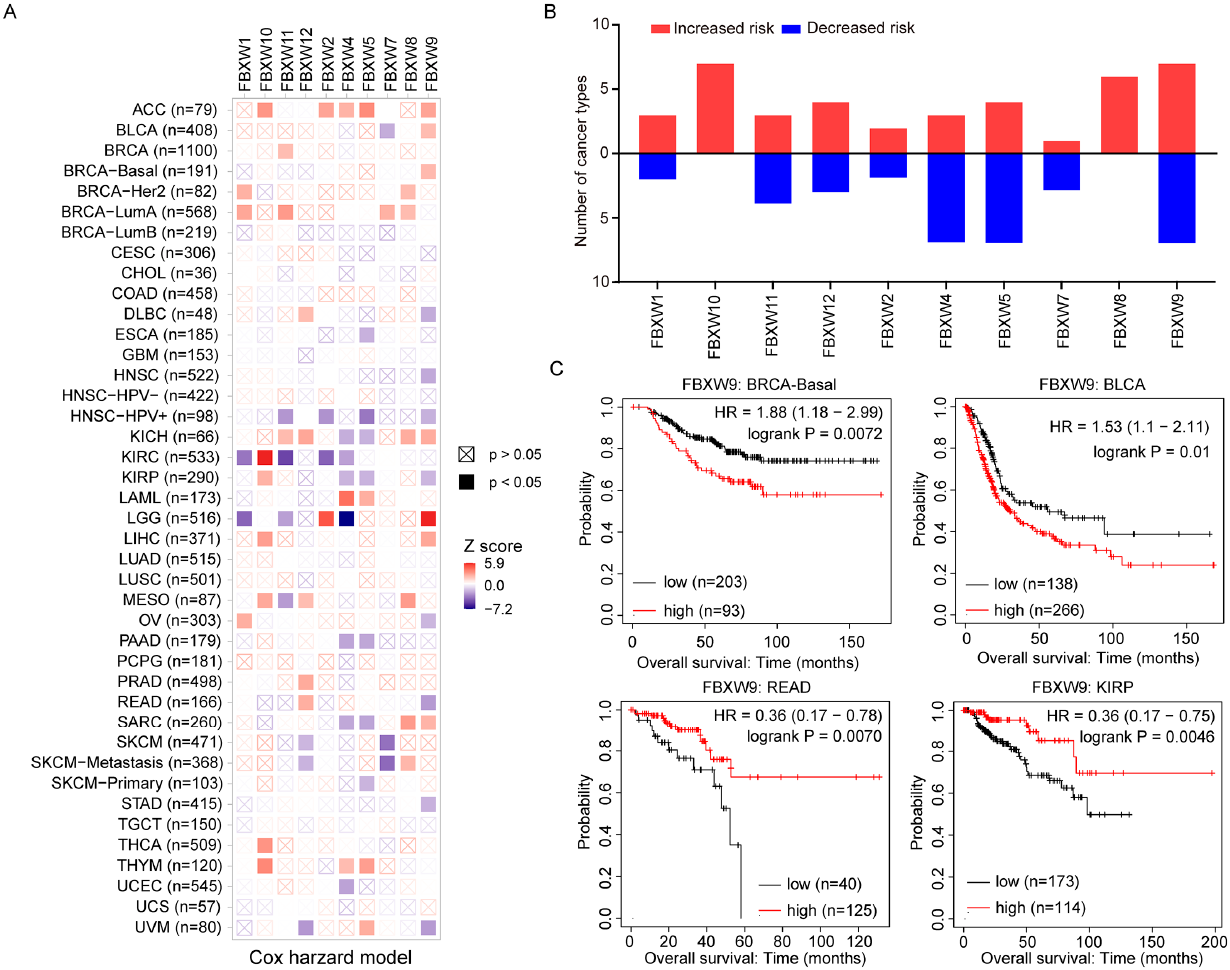
Figure 2. The prognostic value of mRNA levels of FBXWs in multiple cancer types. ( A ) Analysis of the association between mRNA expression of FBXWs with overall survival of patients with 41 cancer types (including subtypes). ( B ) High expression of FBXW9 was associated with poor overall survival of BRCA-Basal and BLCA and good overall survival of READ and KIRP. ( C ) Kaplan-Meier plot of overall survival of patients with BRCA-Basal, BLCA, READ or KIRP.